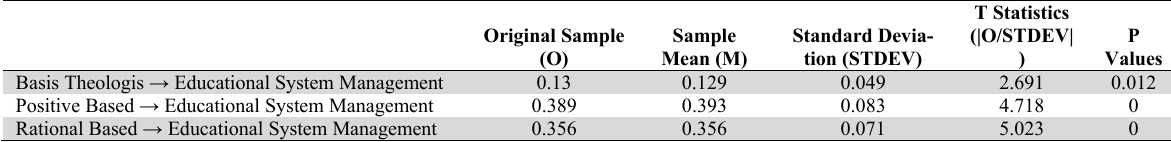
Hypotheses Testing Results